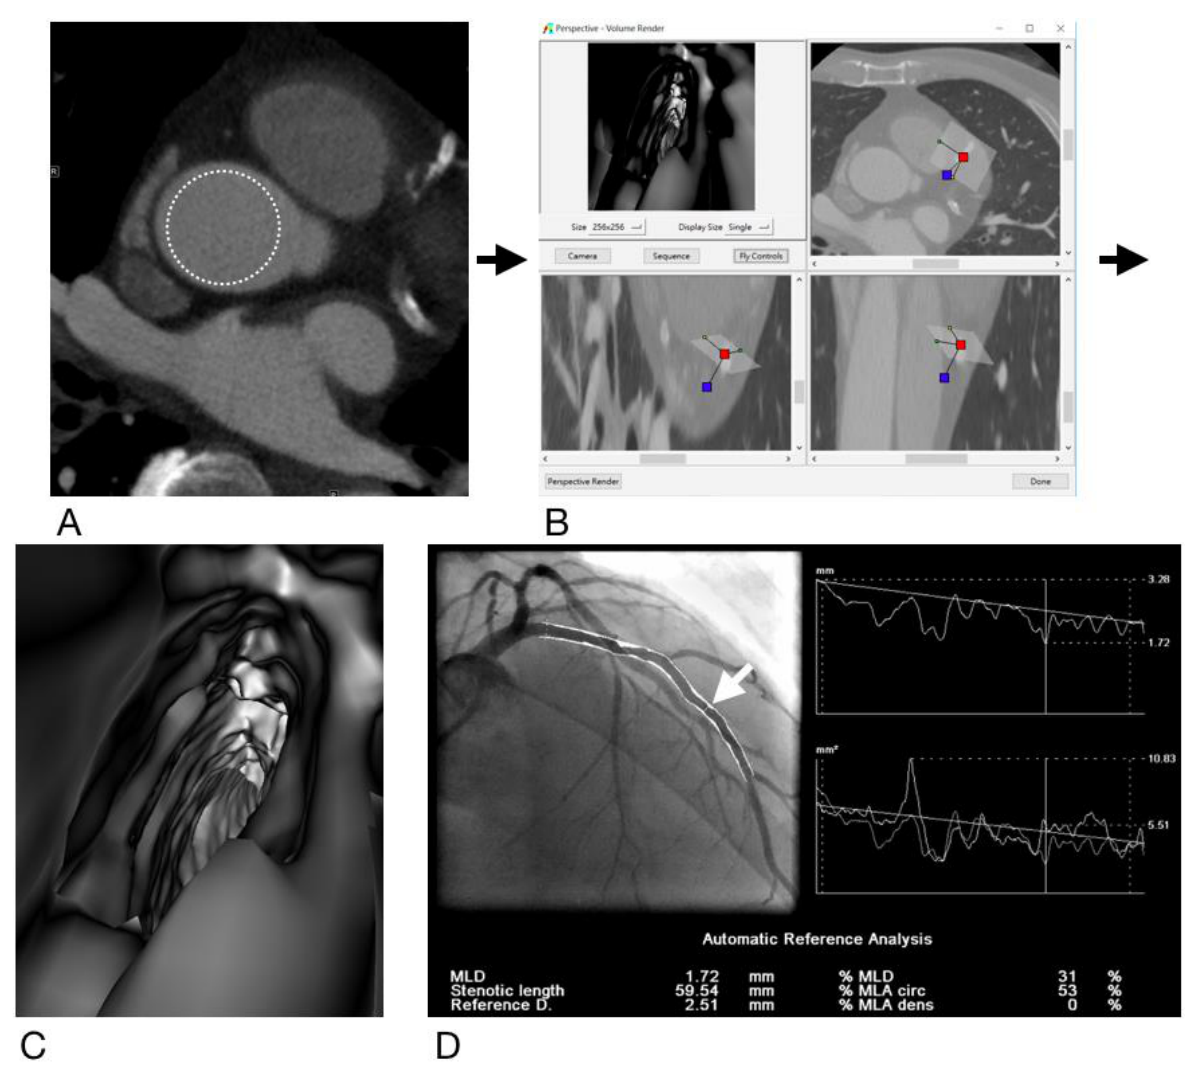
Figure 1. Flowchart showing image post-processing steps from original DICOM images to generat- ing VIE images. The CT attenuation is measured in the ascending aorta on original DICOM images ( A ) to set the approximate threshold for generation of VIE ( B ), revealing intimal hyperplasia in a stent placed in the proximal- to middle- left anterior descending artery ( C ). This is then compared with the results of invasive coronary angiography ( D ), which also shows intimal hyperplasia with 31% stenosis